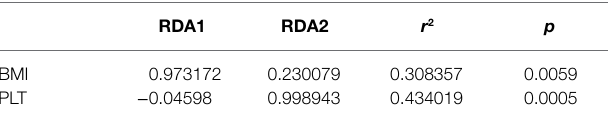
TABLE 3 | dbRDA envfit analysis of the correlation between fecal microbiota and explanatory variables in native Tibetans and Han